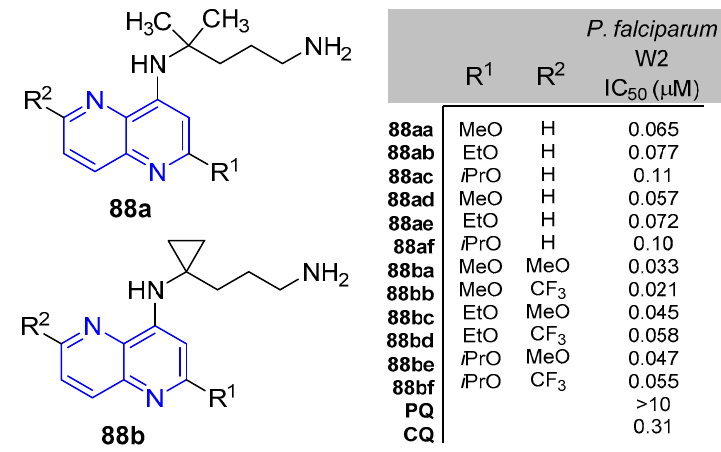
Figure 20. Evaluation of 1,5-naphthyridine-based molecules as antimalarial agents.